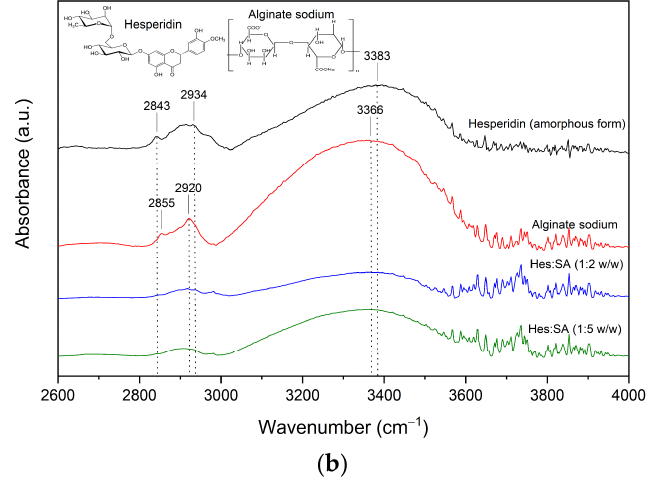
Figure 5. The FT-IR analysis—Hesperidin (amorphous form), Alginate sodium, Hes:SA 1:2, Hes:SA 1:5; ( a ) range 400–1800 cm −1 , ( b ) range 2600–4000 cm −1 .